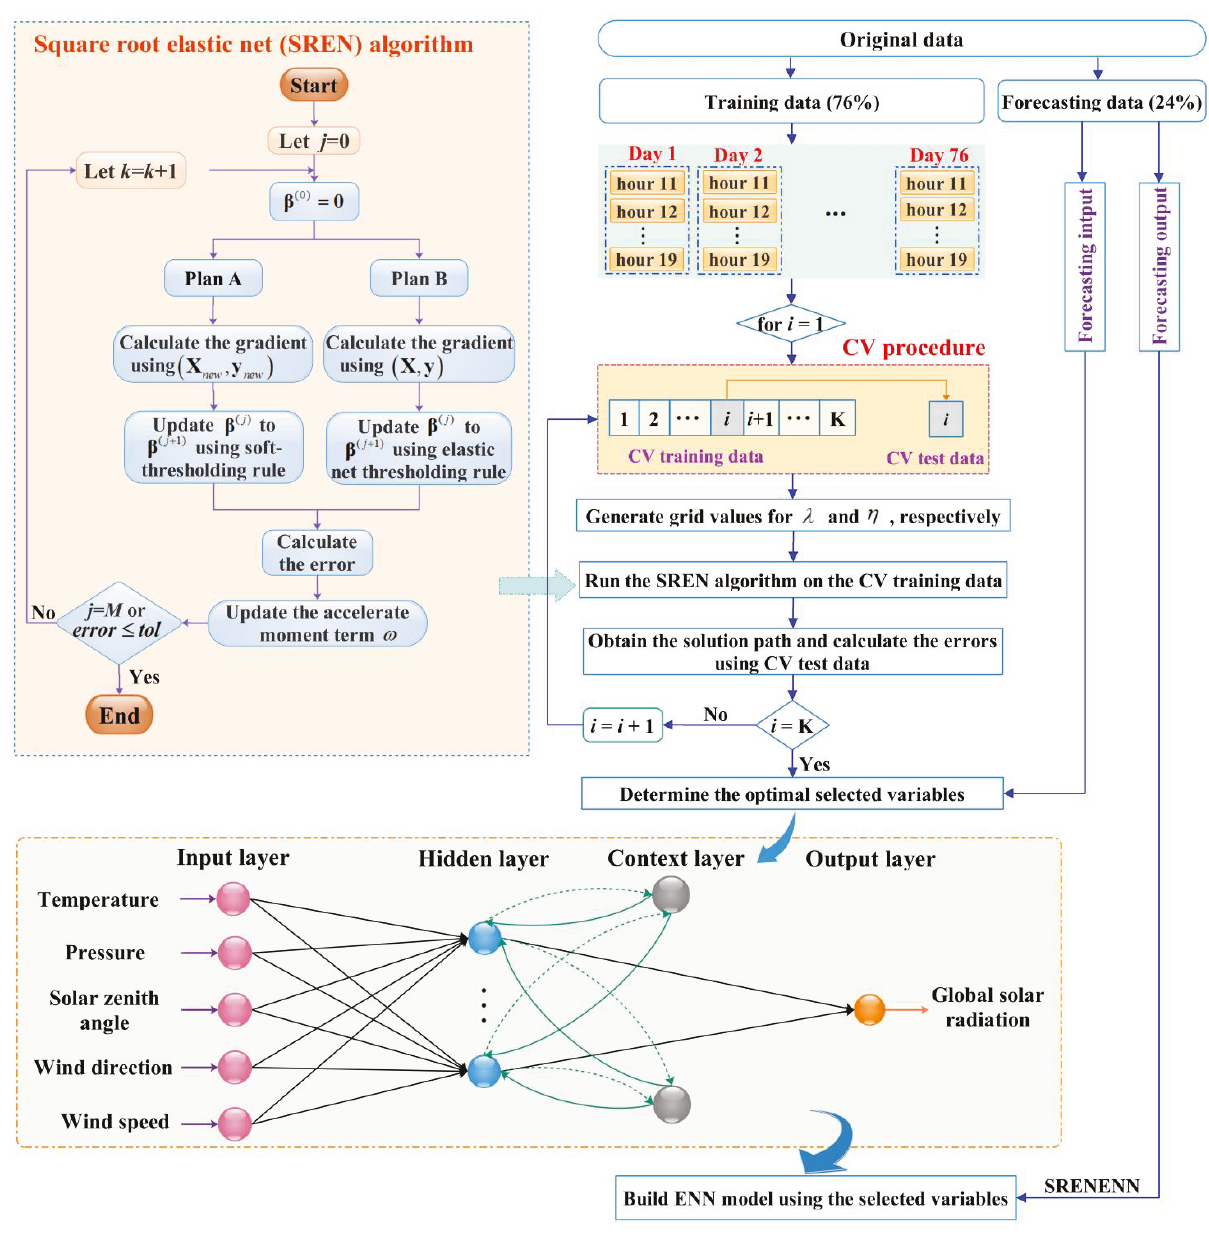
Figure 2: Flowchart of SRENENN